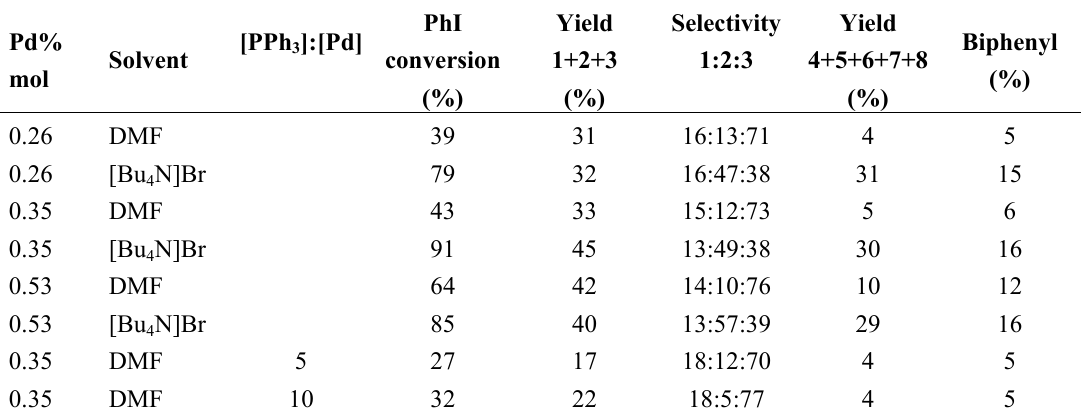
Table 2. Results of the Heck coupling of iodobenzene with cyclohexene catalyzed by O +CeO in DMF and in [Bu N]Br. Pd/Al 2 3 2 4 PhI [PPh Pd% ]:[Pd] 3 Solvent conversion mol